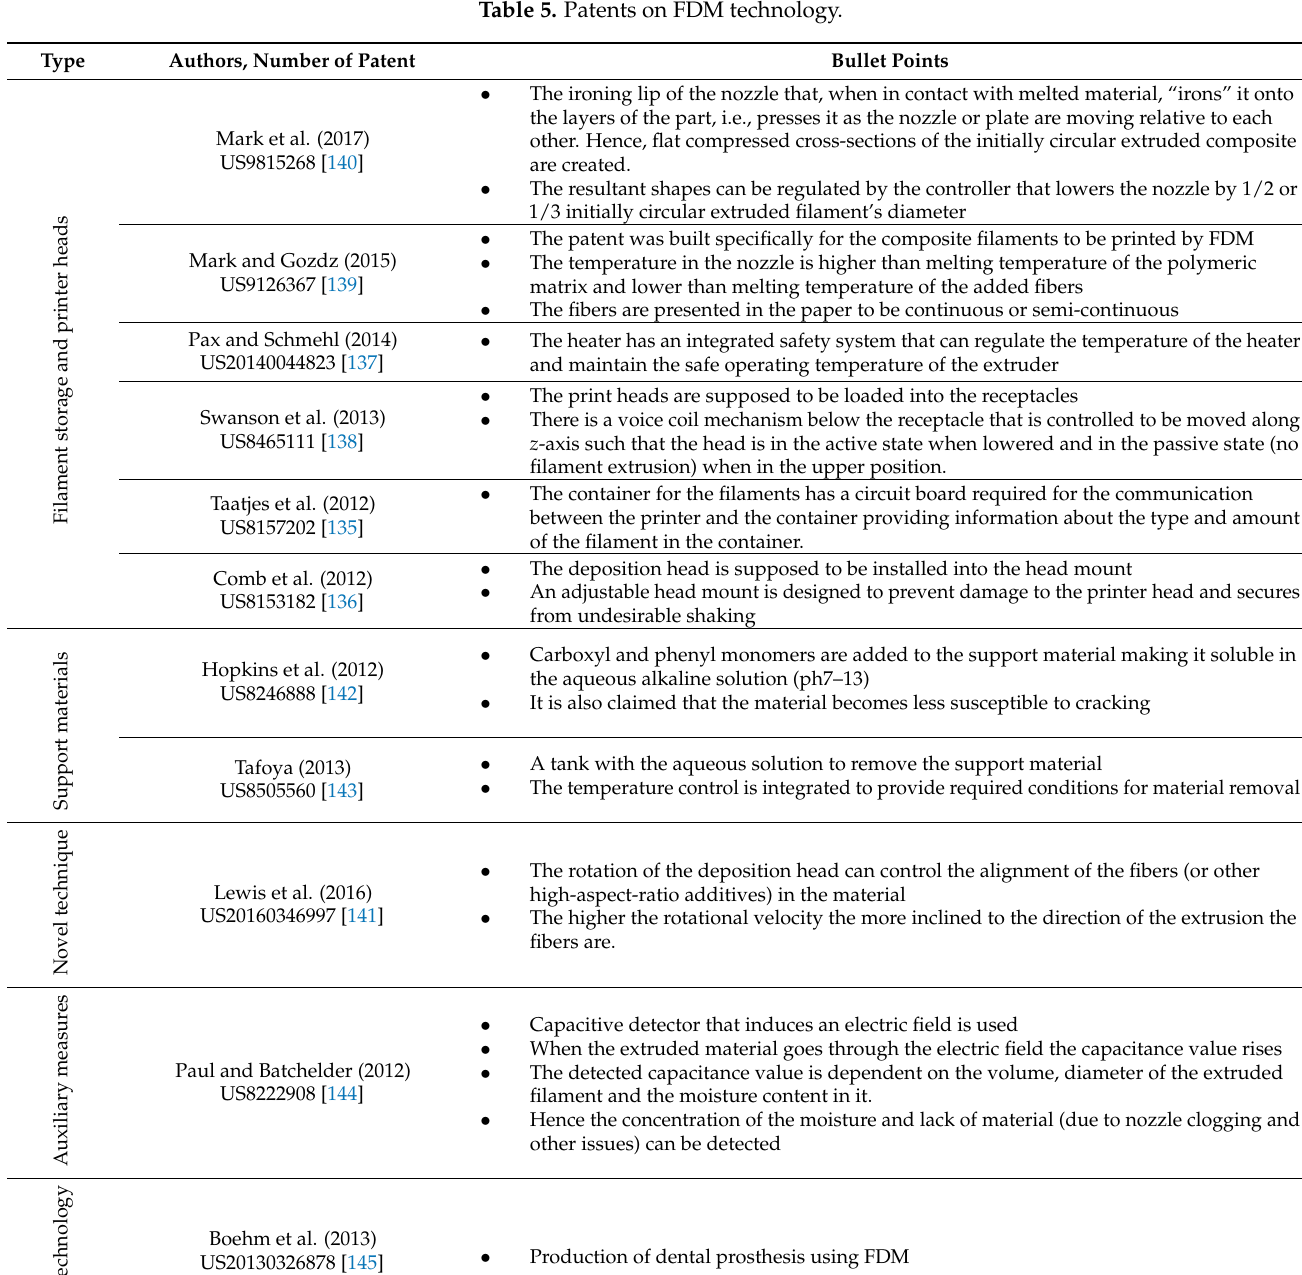
Table 5. Patents on FDM